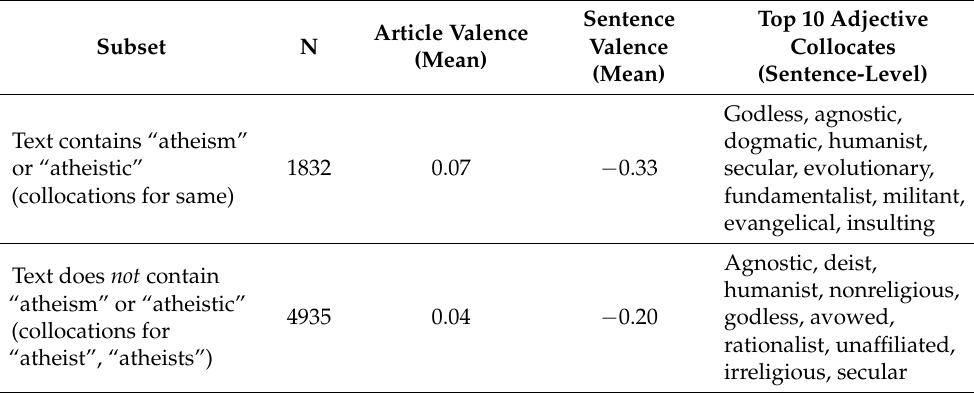
Table 5. Tone and top collocates in articles on non-foreign topics: atheism vs. atheist(s).